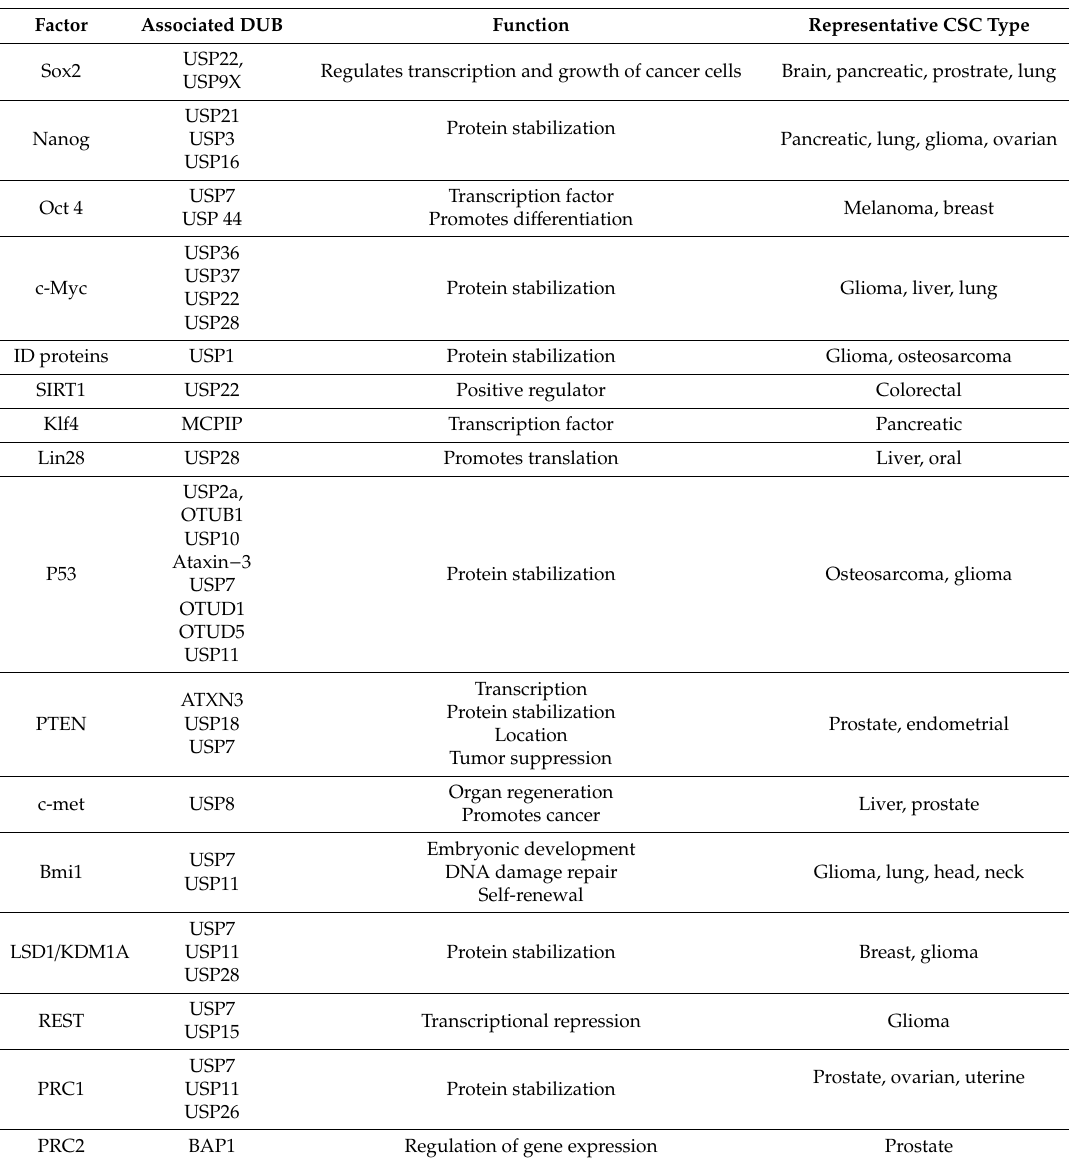
Table 1. Deubiquitinating enzymes associated with stem cell